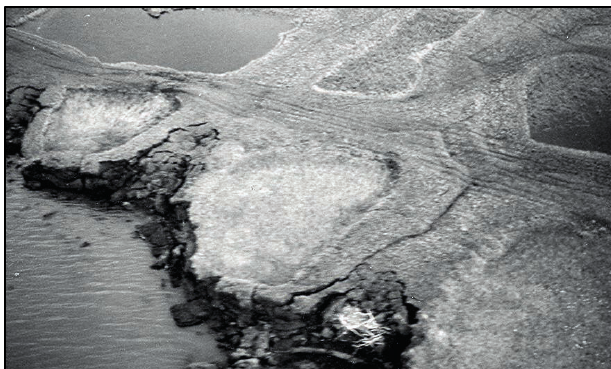
Fig. 3 High level ice wedge polygon pond drained because of riverbank